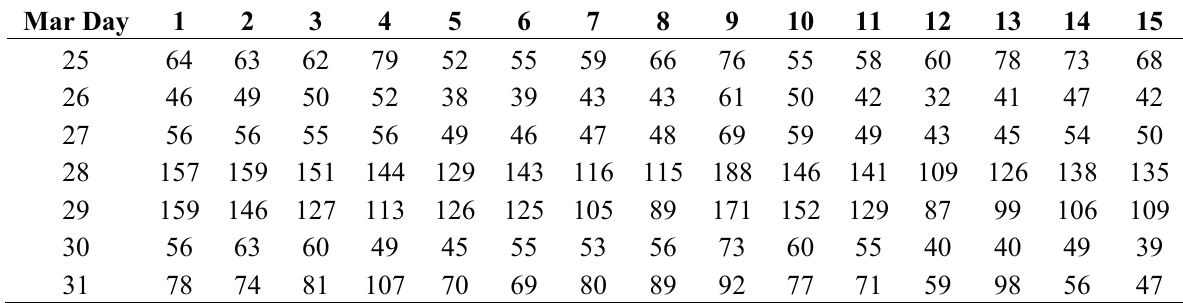
Table 1. P M 10 concentrations measured in 15 areas of Incheon